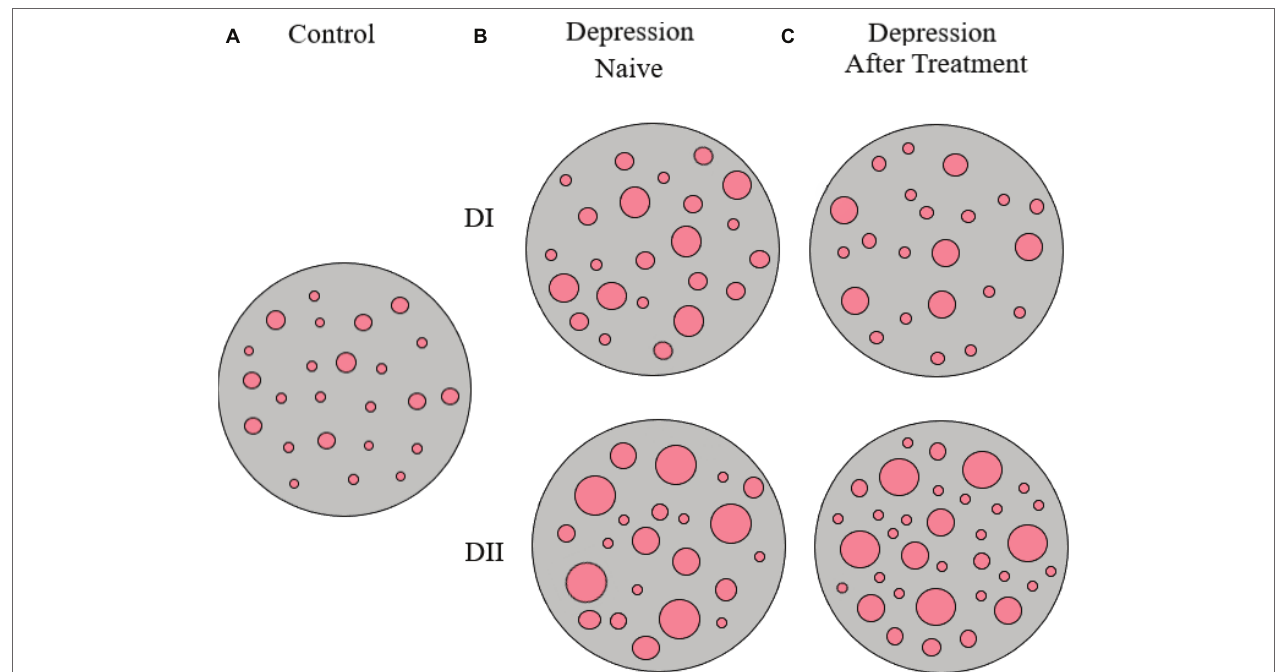
FIGURE 2 | Schematic representation of SERT clusters in the membrane of lymphocytes from control (A) and depression patients (B,C) . Analysis of SERT clustering in naïve depression patients allowed the differentiation of two subpopulations of depression patients (D-I and D-II) that primarily differ in the average size of SERT clusters. After 8 weeks of antidepressant treatment, there were no changes in SERT cluster number and size for D-I patients, but there was an increase in the number of SERT clusters in D-II patients (for more details see text, and Rivera-Baltanas et al.,